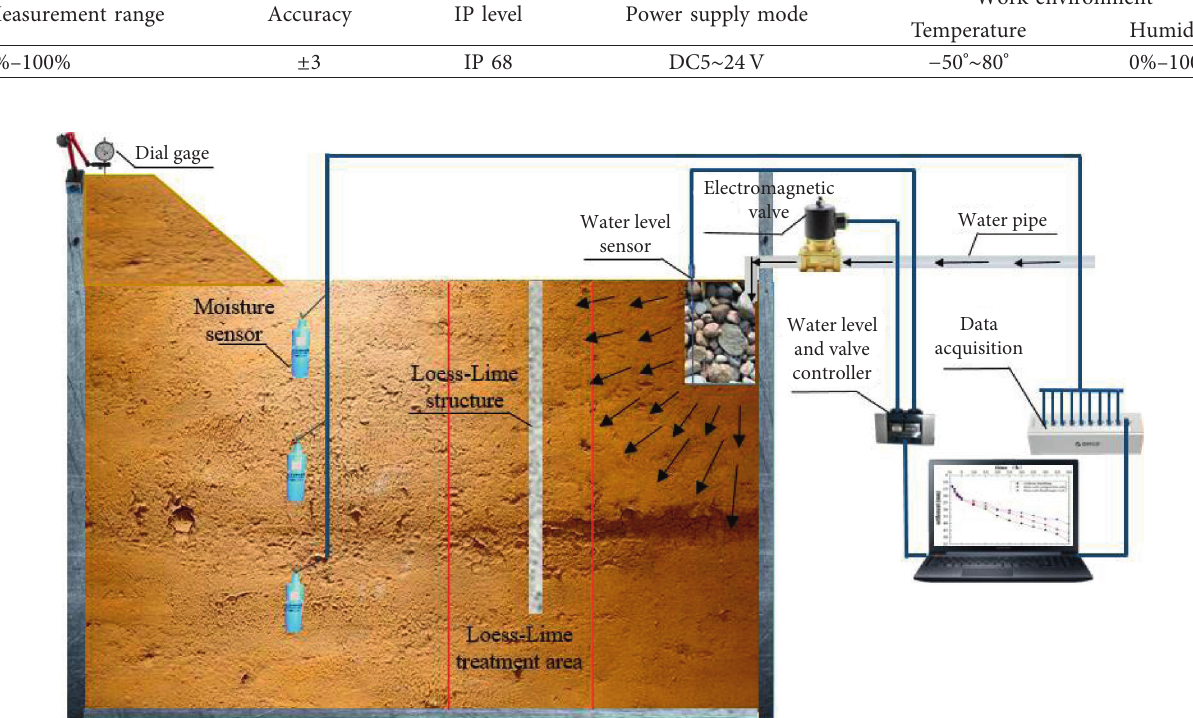
Figure 3: Test system and location of moisture